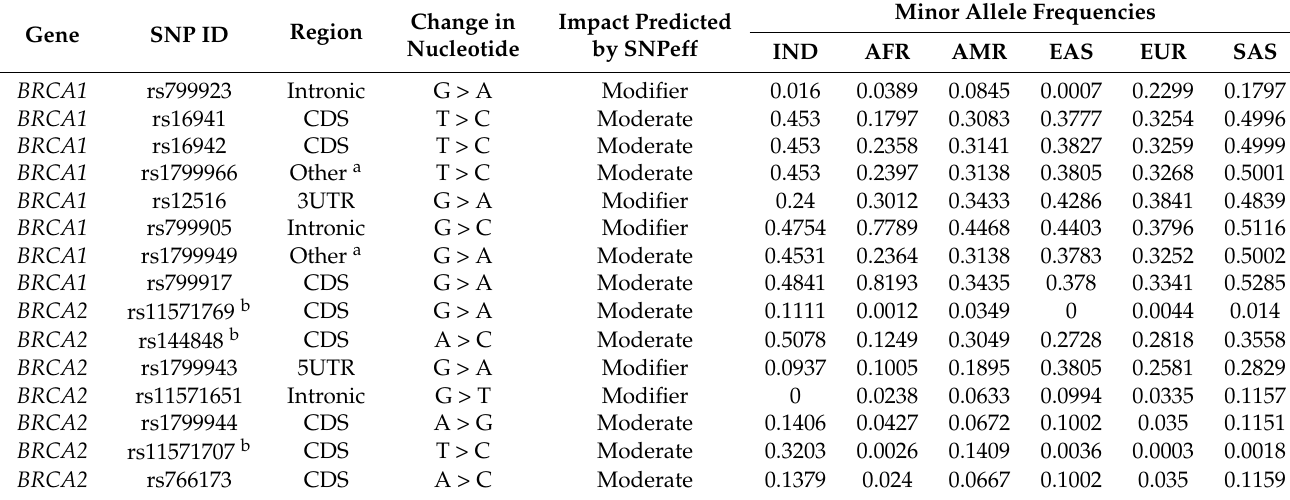
Table 1. Description of the variants in the BRCA1 and BRCA2 genes in the Amerindian individuals (IND) and continental populations (African (AFR), American population (AMR), East Asian (EAS), European (EUR), and South Asian (SAS)) described in the 1000 genomes database.